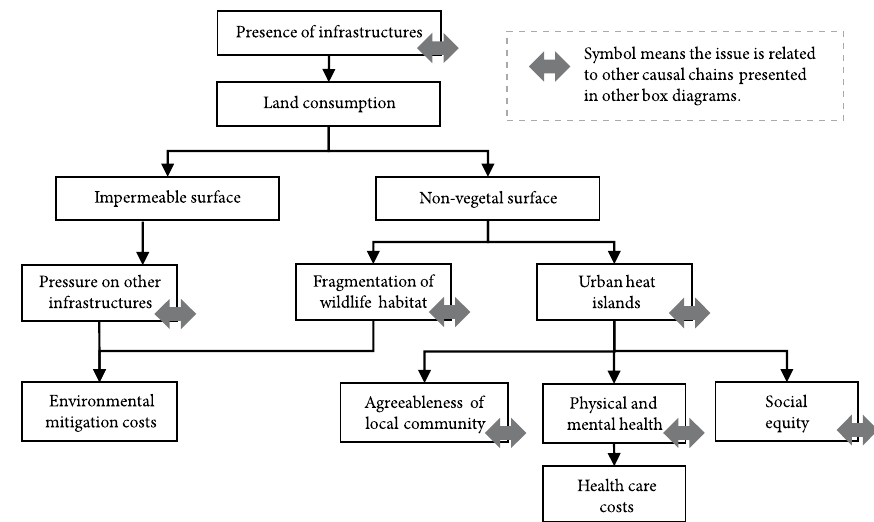
Fig. 2. Causal chains diagram focused on the presence of